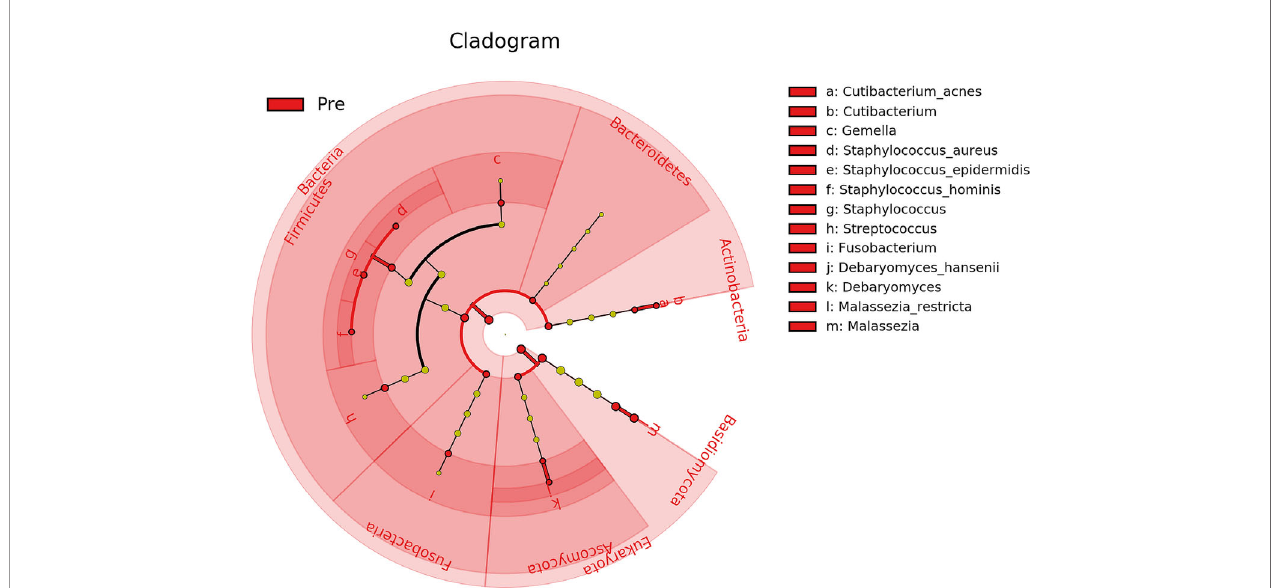
FIGURE 5 | Cladogram of differential taxa identi fi ed between samples collected before (Pre/Baseline) and after (Post) the intervention of AIONX ® cleanSURFACES ® . Taxa that were enriched in Pre/Baseline are indicated with red nodes, while taxa that were enriched in the Post intervention samples are indicated with blue nodes. Signi fi cant (Kruskal-Wallis, p ≤ 0.05 and log (LDA) ≥ 1.5) features are shown and are composed of 21 enriched taxa within the Baseline intervention group. Notably, the Bacteria as a domain were signi fi cantly reduced in samples Post-AIONX ® intervention. No enriched microbial features were observed within the Post-AIONX ® intervention